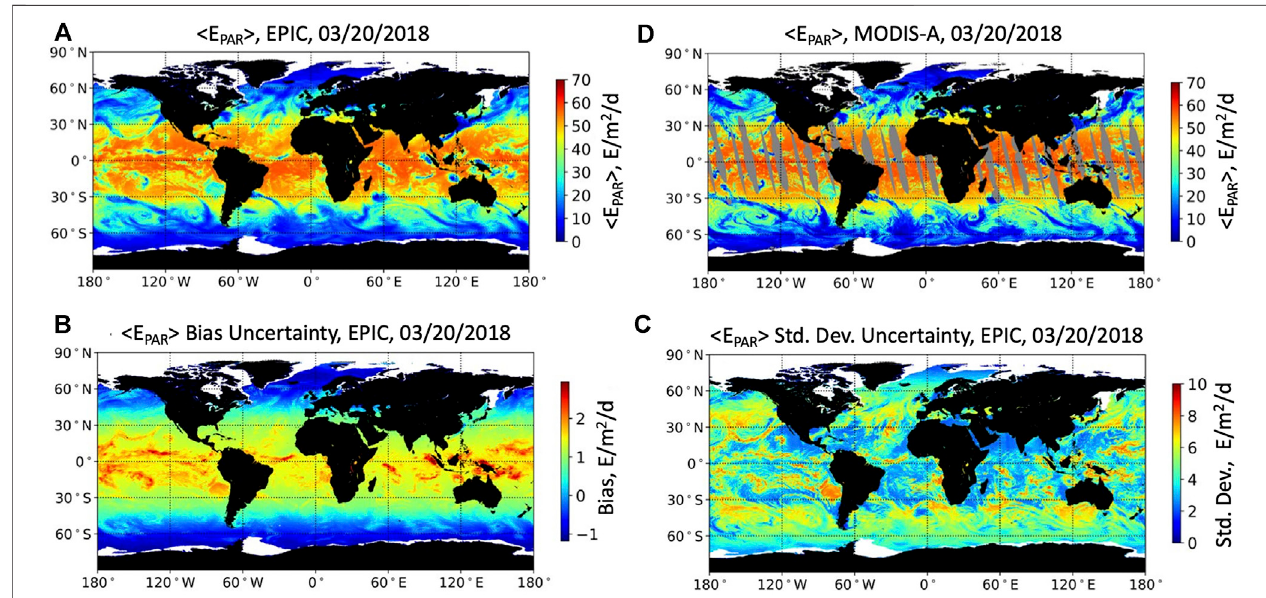
FIGURE8|(A) < E PAR > derivedfromEPICimageryofMarch20,2018; (B,C) Algorithmuncertainity(bias,standarddeviation)associatedtoEPIC < E PAR > estimates; (D) < E PAR > derived from MODIS-Aqua imagery of March 20, 2018.